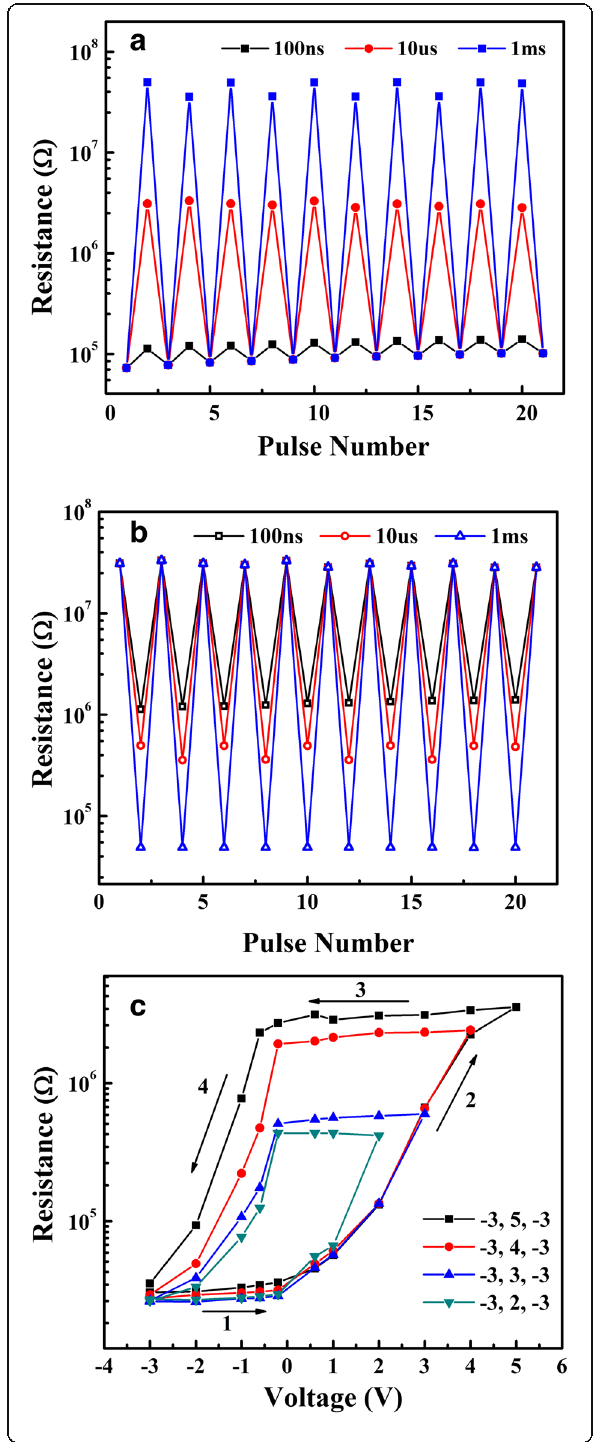
with 100 ms width and then applied by a + 5 V ( − 5 V) pulse with varied pulse widths of 100 ns, 10 μ s, and 10 ms, respectively. The corresponding resistance transition from LRS (HRS) to intermediate resistance states or HRS (LRS). c R – V hysteresis loops controlled by pulse voltage. The Pt/Nd:STO/In device was firstly set to LRS by a pulse of − 3 V, followed by sweeping the pulse to + 2 V (or + 3, + 4, and + 5 V) and back to − 3 V with 100-ms pulse width. All the